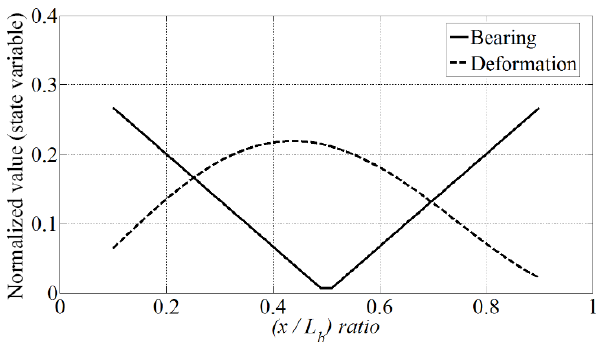
Figure 6. Variation of each state variable at inline 4-cylinder en-